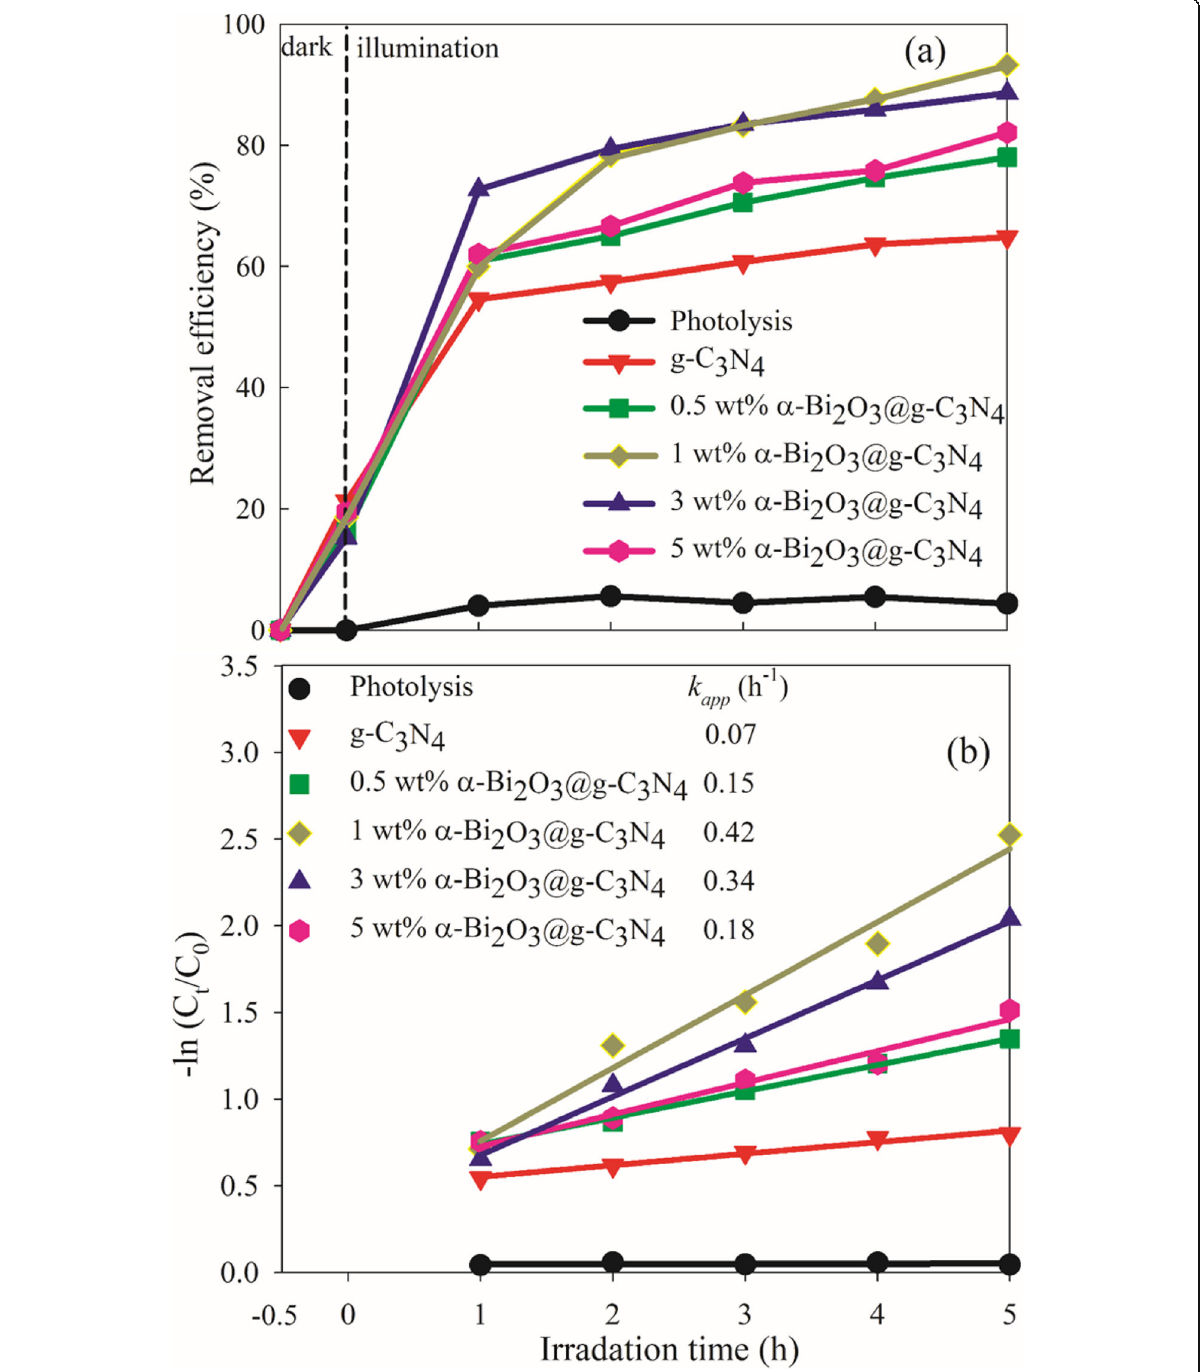
Fig. 7 ( a ) BP-3 removal efficiency achieved with pristine g-C 3 N 4 and α -Bi 2 O 3 @g-C 3 N 4 ( b ) Pseudo-first-order kinetic plots of g-C 3 N 4 and the α - shows the lowest photocatalytic activity [50]. The PL in- tensity of bare α -Bi O is the lowest and is almost negli- 2 3 gible. Hence, the PL peak intensity of the composite is lower than that of pristine g-C N , which confirms the 3 4